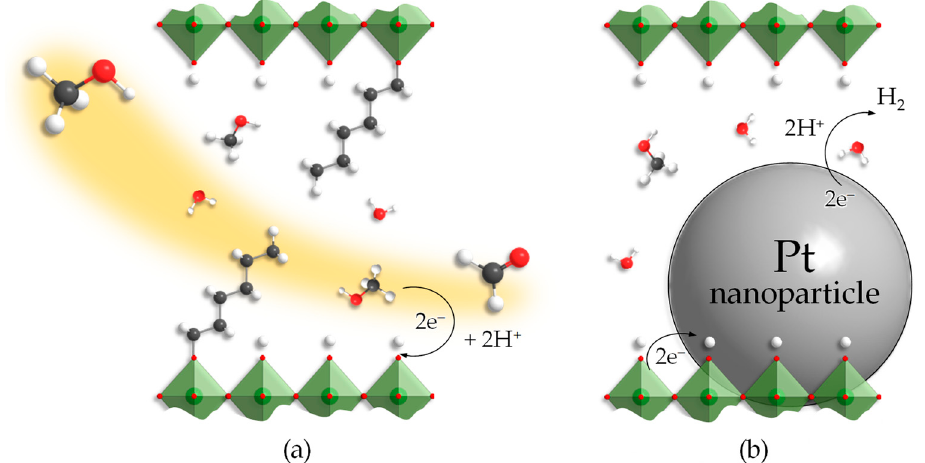
Figure 8. Potential explanations of the photocatalytic properties of inorganic–organic derivatives: increasing of the interlayer reaction zone accessibility ( a ), reduction of Pt nanoparticles in this zone ( b ).